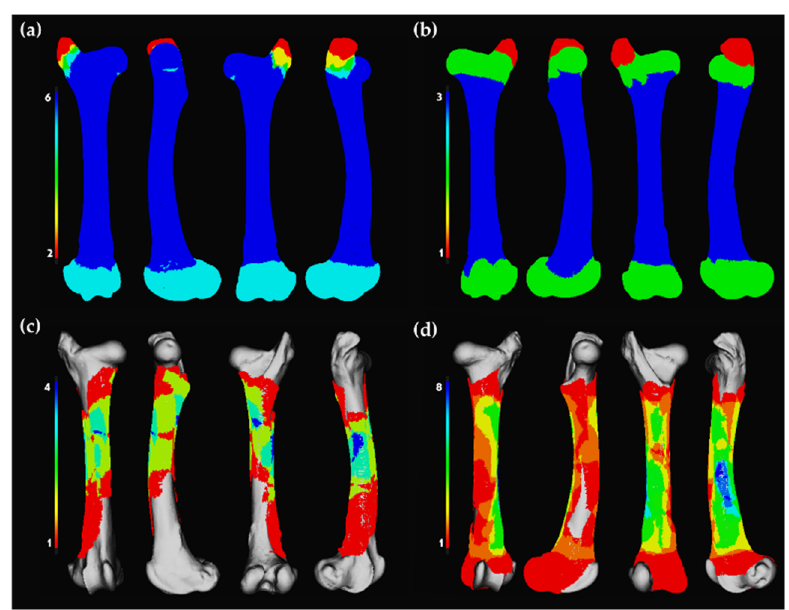
Figure 2. Heatmaps generated in Ikhnos . Bone preservation for right and left femora modified by wolf populations divided by ( a ) right femora modified by wild wolves; ( b ) left femora modified by wild wolves; ( c ) right femora modified by captive wolves; ( d ) left femora modified by captive wolves. Red-shaded portions indicate areas of lowest survivorship, whereas blue-shaded portions indicate areas of highest survivorship, namely the MNE.